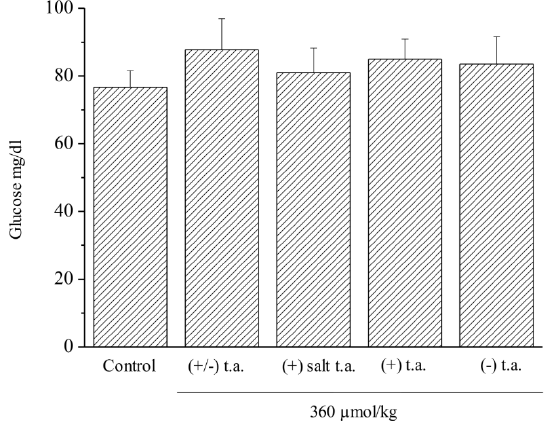
Figure A1. Subchronic toxicity treatments: glycaemia levels. Effects of 15-day subchronic toxicity treatments with 360 µmol/kg (+/−) t.a., (+) salt t.a., (+) t.a., (−) t.a. on plasmatic levels of glucose. Antioxidants 2020 , 9 , x FOR PEER REVIEW Table A1. Organ mass variation following 15-day administration of (+/−) thioctic acid, (+) salt thioctic acid, (+) thioctic acid, (−) enantiomer.